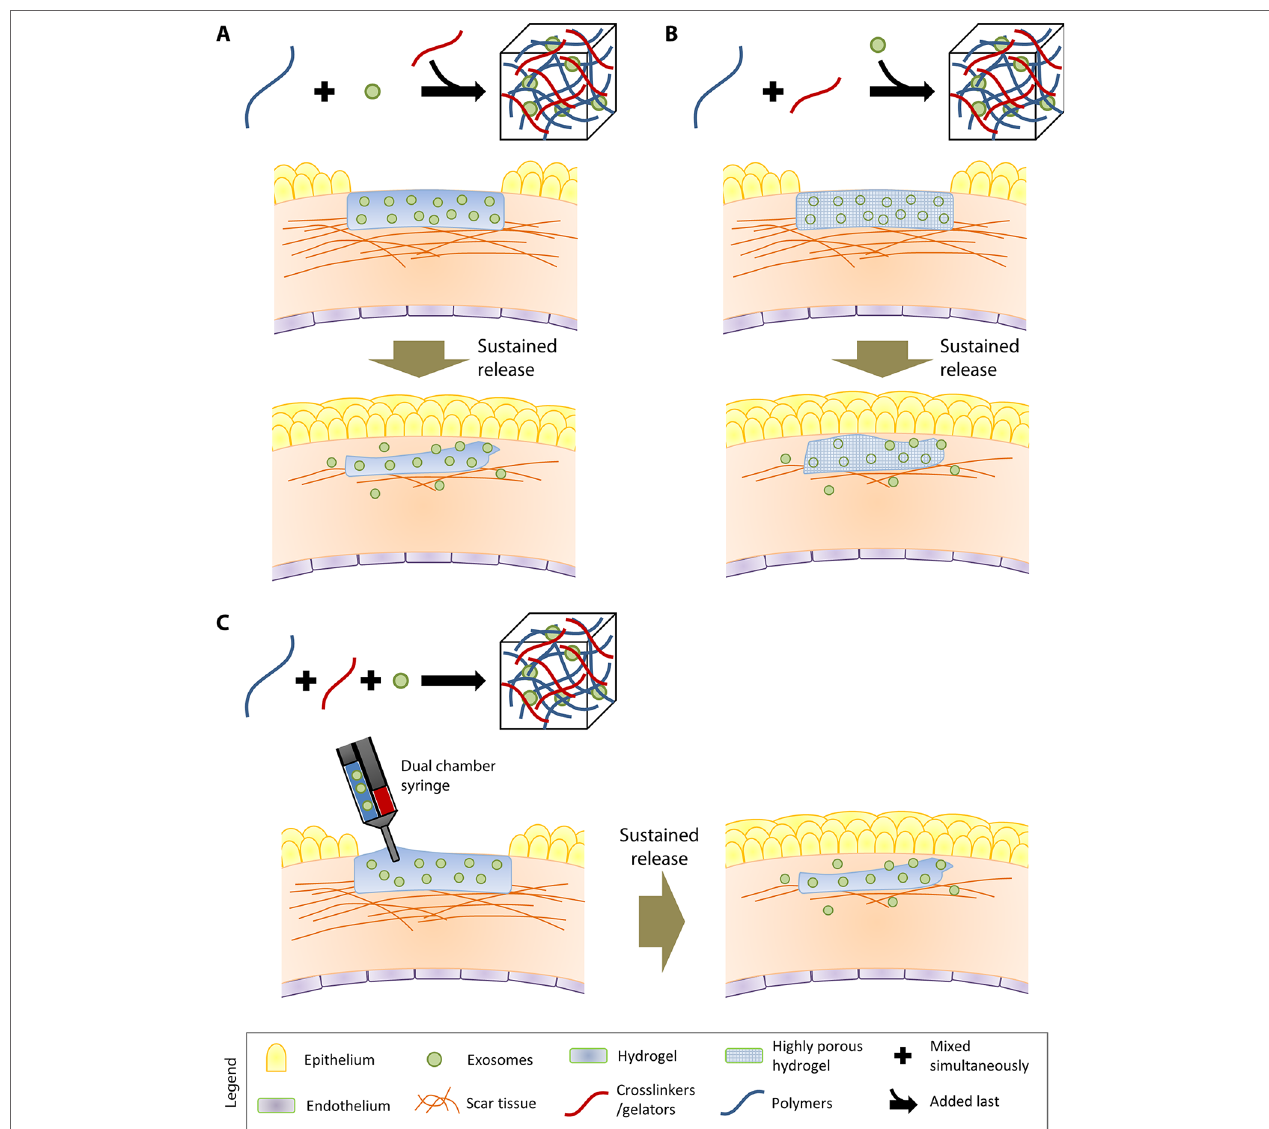
FIGURE 1 | Three different methods to incorporate exosomes in hydrogels. In the illustrations, the therapeutic application of the exosome-loaded hydrogels is exemplified by their role in reducing scar tissue in the cornea. (A) The first strategy involves incorporation of exosomes by mixing with the polymers, followed by addition of crosslinkers to gel the composite. (B) The second strategy involves physically incorporation of exosomes after the gelation of the hydrogel. (C) The third strategy involves mixing the polymers, exosomes, and crosslinkers simultaneously. In situ gelation can be achieved by injecting the three hydrogel components using a dual-chamber syringe directly at the target